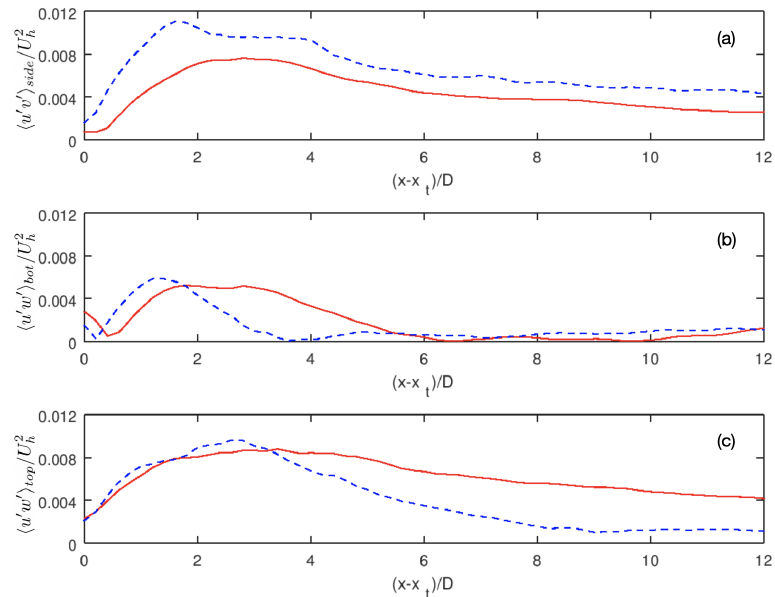
Figure 13. The averaged Reynolds stress on the surface of the control volume for ( a ) on the two side surface of the control volume (Equation (19)), ( b ) on the bottom surface of the control volume Equation (20) and ( c ) on the top surface of the control volume Equation